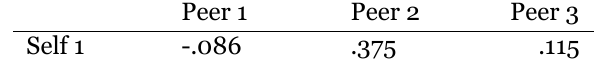
Pearson Correlation Matrix Between Self- and Peer Ratings in Student Group Work (N =